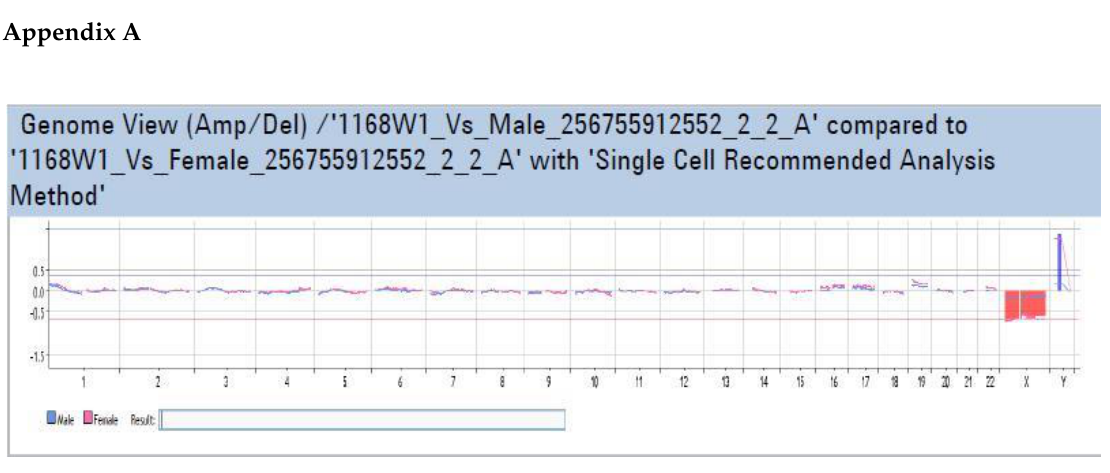
Figure A1. Male embryo, euploid, exon 6, c.470T>C.